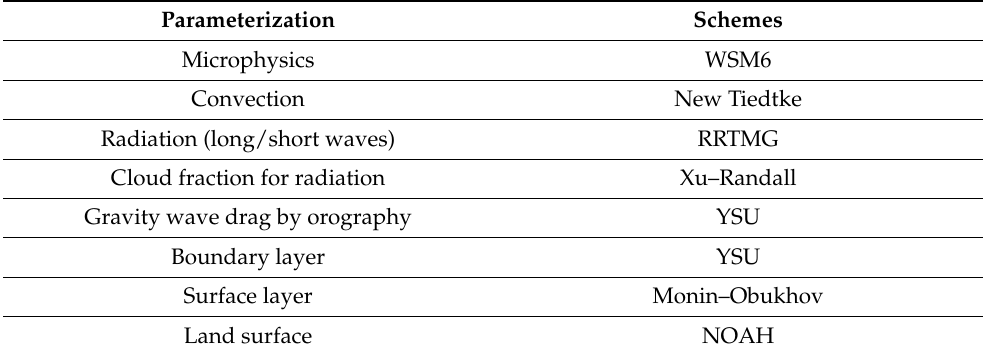
Table 1. Parameterization schemes used in our MPAS